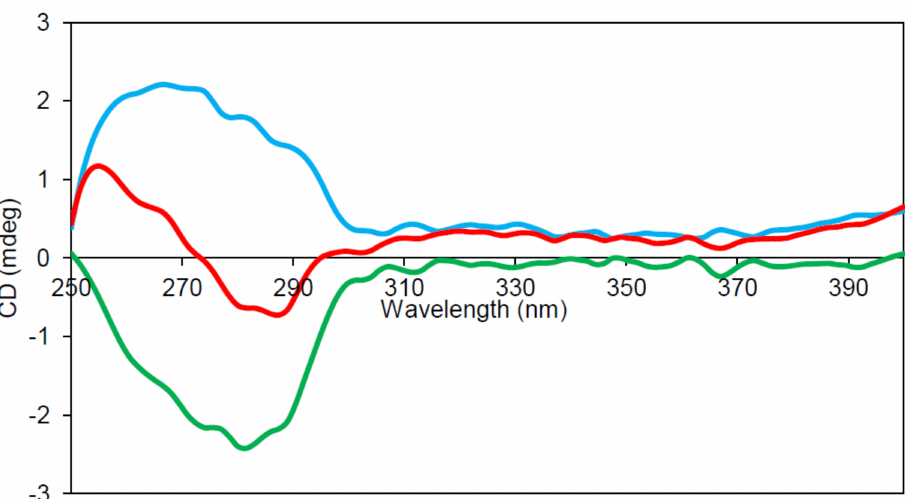
Figure 5. Near-UV circular dichroism (CD) of the two ZnT8c variants. Representative (n = 3) near-UV CD spectra of 0.4 mg/mL ZnT8cR (blue) and ZnT8cW (green) in 50 mM Tris, 300 mM NaCl, 100 mM sucrose, 100 µ M Tris(2-carboxyethyl)phosphine hydrochloride (TCEP), pH 8. Subtracting the ZnT8cR spectrum from that of ZnT8cW provides the expected CD of W325 in the protein alone